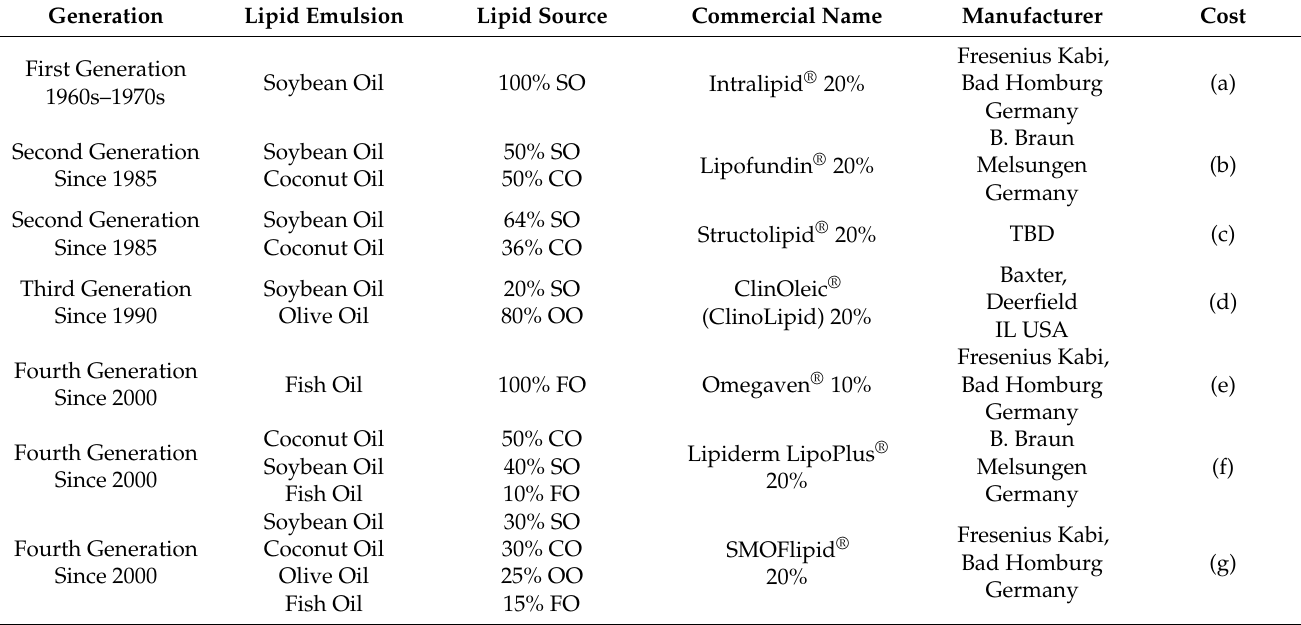
Table 4. Lipid Emulsions for Parenteral Nutrition